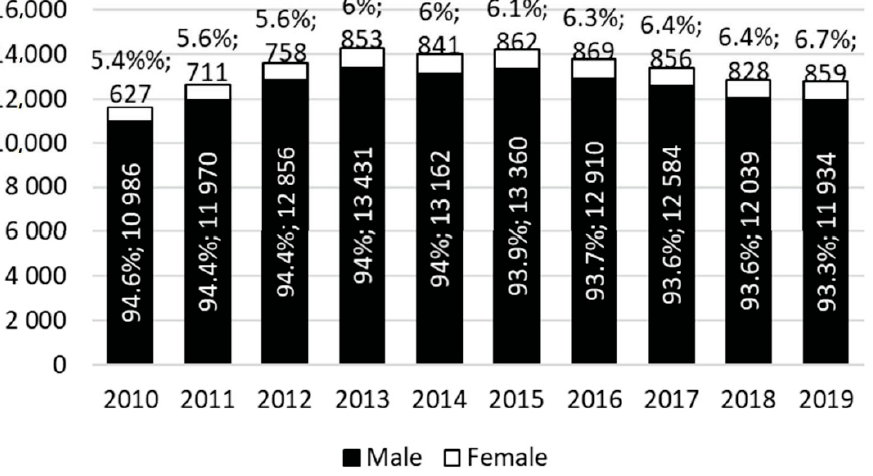
Figure 1. Prisoners in Portuguese prison establishments by sex (2010–2019). Source: own elaboration, based in (DGPJ 2020).